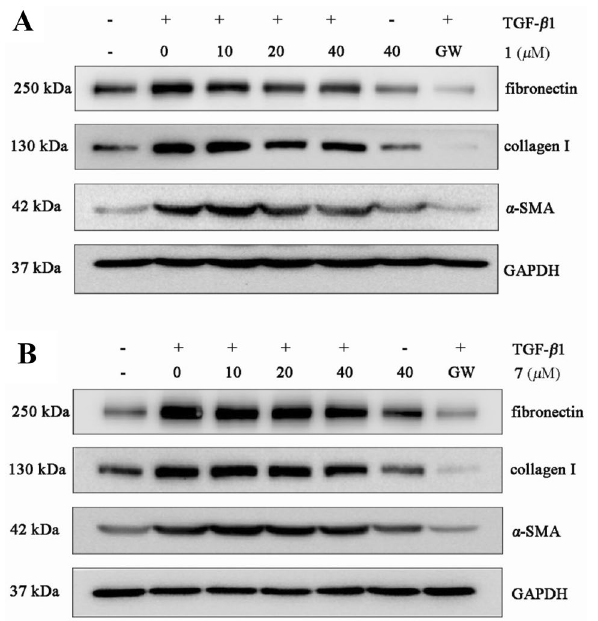
Fig. 8 Western blot analysis showing that 1 and 7 block TGF- β 1- mediated renal fibrosis. NRK-52e cells were preincubated with differ- ent concentrations of the compounds for 48 h before TGF- β 1 (10 ng/ mL) treatment. Cell lysates were immunoblotted with antibodies against fibronectin, collagen I, α -SMA, and GAPDH Fig. 9 Western blot analysis showing that 1 and 7 inhibit TGF- β 1–